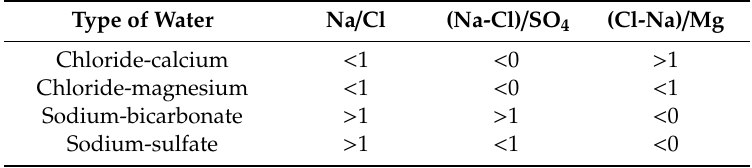
Table 3. Types of water genetic classification according to the Sulin system [23]. Type of Water Na / Cl (Na-Cl) / SO 4 (Cl-Na) / Mg Chloride-calcium < 1 < 0 > 1 <